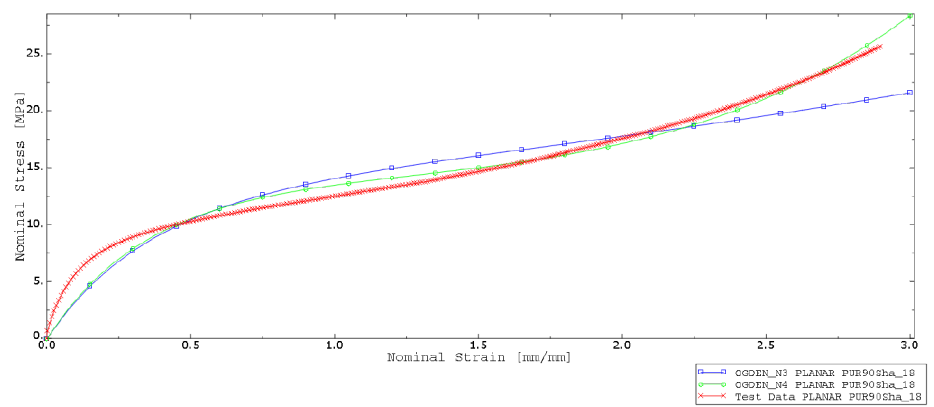
Figure 9. Stress – strain curves — experimental (red curve — test data) and numerical data fitting (Ogden, Arruda – Boyce, and reduced polynomial with 1 and 3 model parameters) for 80 ShA.